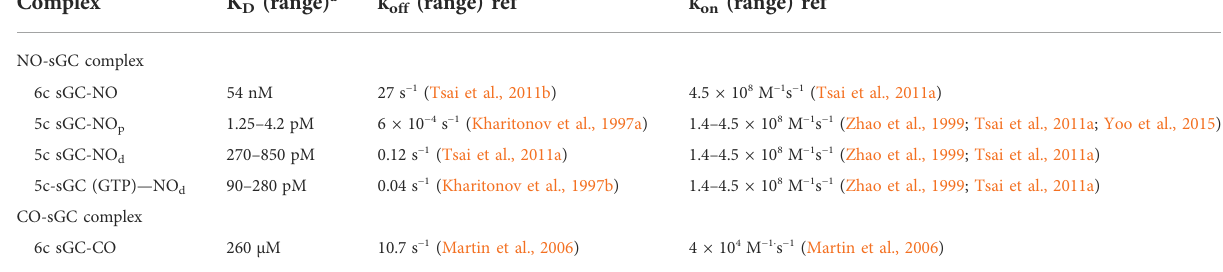
TABLE 1 Ligand speci fi cities of the α 1 β 1 sGC.